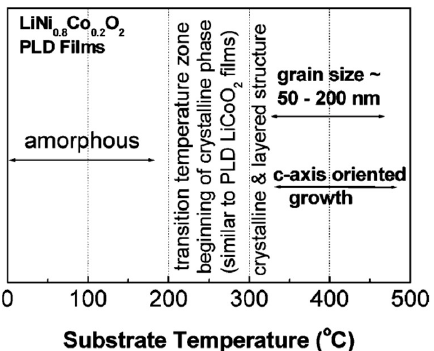
Figure 6. Phase diagram of microstructure development in PLD LiNi 0.8 Co 0.2 O 2 films as a function of